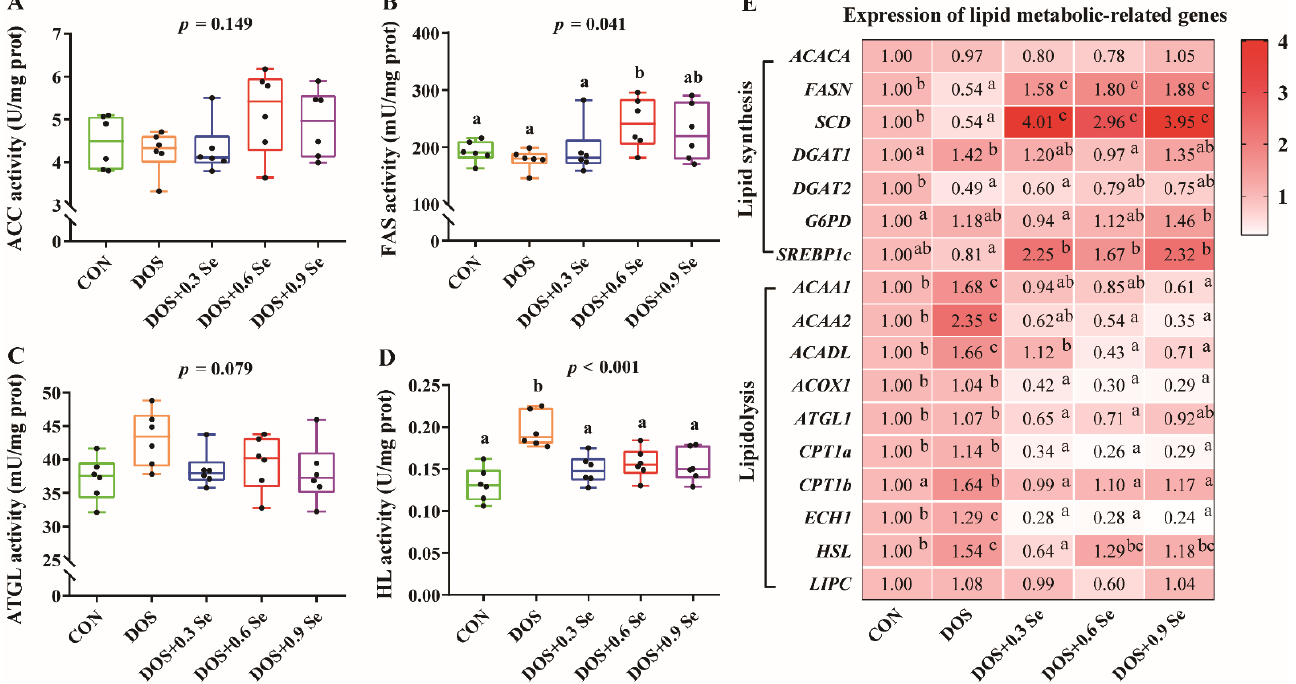
Figure 2. Effects of dietary oxidative stress and OH-SeMet supplementation on lipid metabolism related enzyme activity and expression of lipid metabolic-related genes in the liver of growing-finishing pigs. ( A ) Acetyl-coa carboxylase (ACC) activity; ( B ) Fatty acid synthase (FAS) activity; ( C ) Adipose triglyceride lipase (ATGL) activity; ( D ) Hepatic lipase (HL) activity; ( E ) Expression of lipid metabolic-related genes. Results were expressed as mean ± SD ( n = 6), different letters indicate ANOVA p value less than 0.05 which represent there is a significant difference between